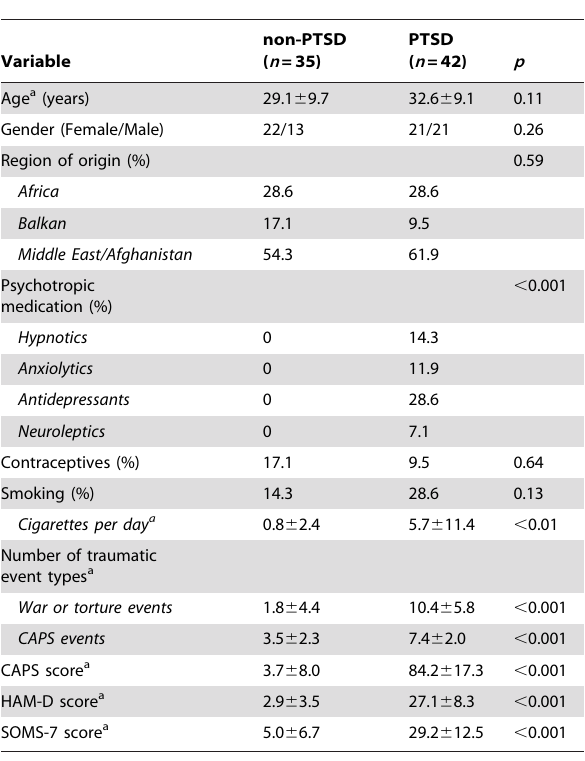
Table 1. Sociodemographic and clinical